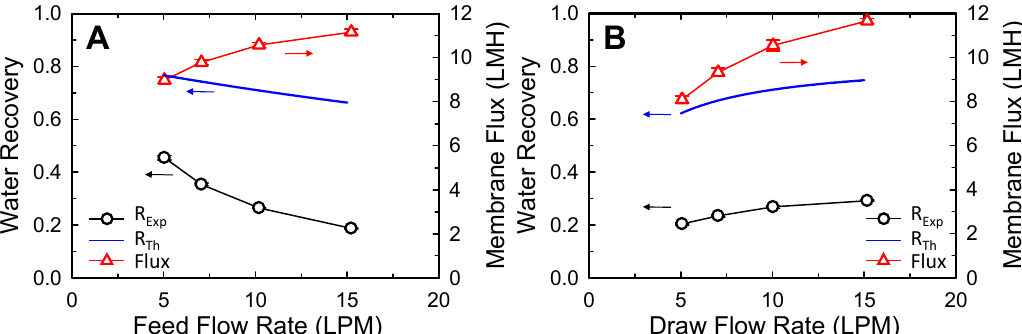
Figure 5 . Water recovery and average membrane permeate flux performance of SW FO module depending on ( A ) feed flow rates and ( B ) draw flow rates. When either the (A) feed or (B) draw flow rate was adjusted, the other stream was fixed to 10 LPM. One SW FO element (15.3 m 2 ) was used with feed and draw solution concentrations of 10 and 58.4 g/L NaCl, respectively. The error bars represent one standard deviation.